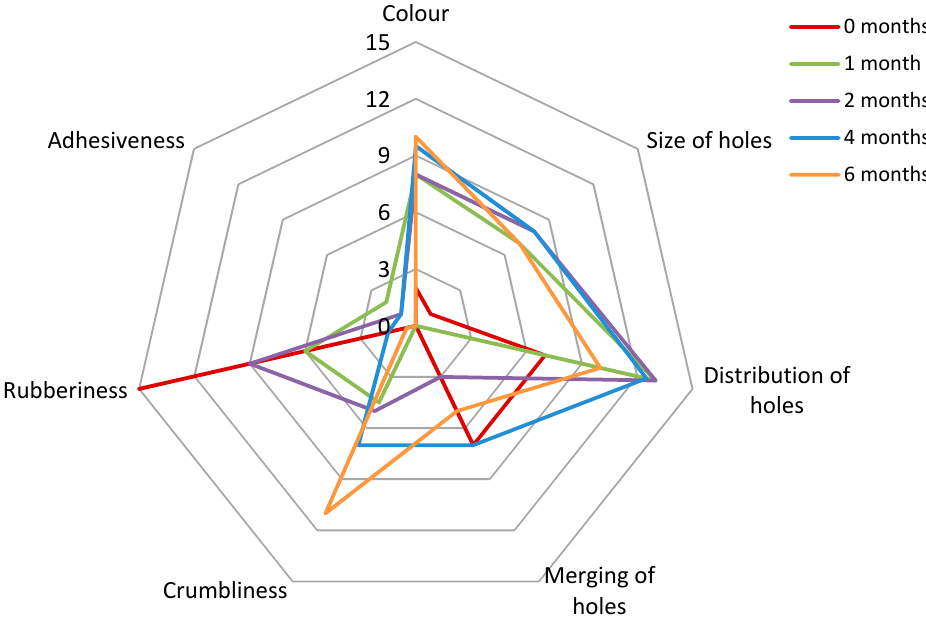
Figure 6. Radar diagram of the appearance and texture attributes of RO-cheese during ripening.